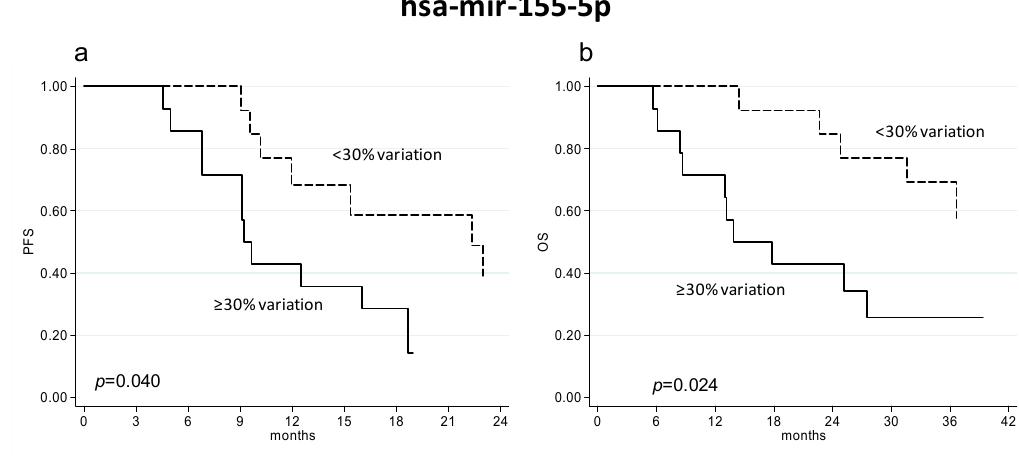
Figure 2. PFS ( a ) and OS ( b ) of patients with an increase ≥ or <30% of circulating hsa-miR-155-5p at the first clinical evaluation. Dashed lines represent patients with miRNA values greater than the median value, whereas continuous lines represent patients with miRNA values lower than the median value.